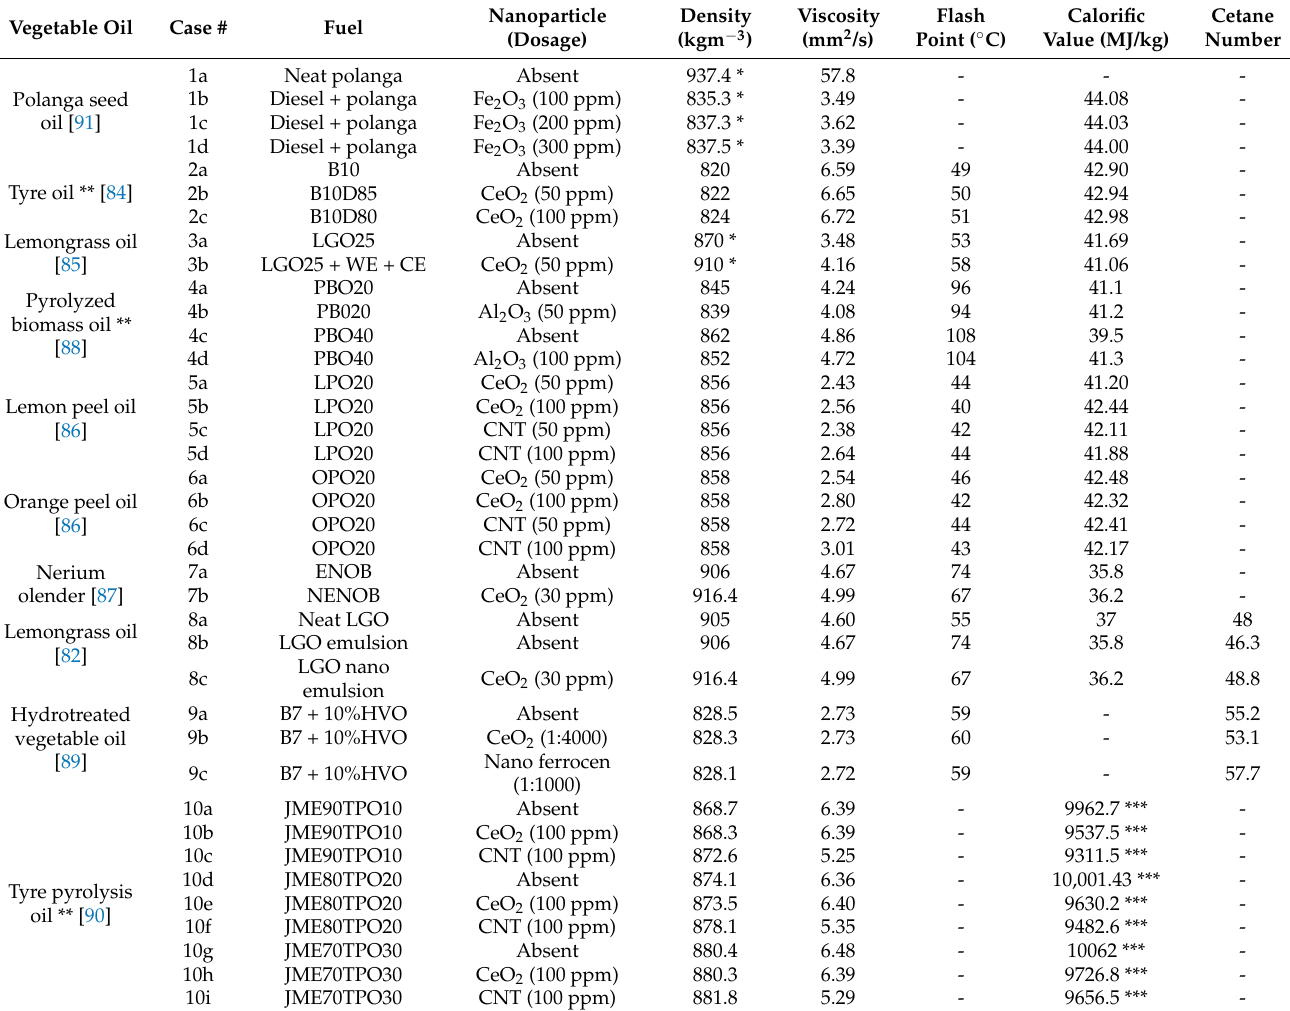
Table 2. Summary of nanoparticles’ effect on fuel properties of vegetable oil/pure bio-oil-based fuels. Vegetable